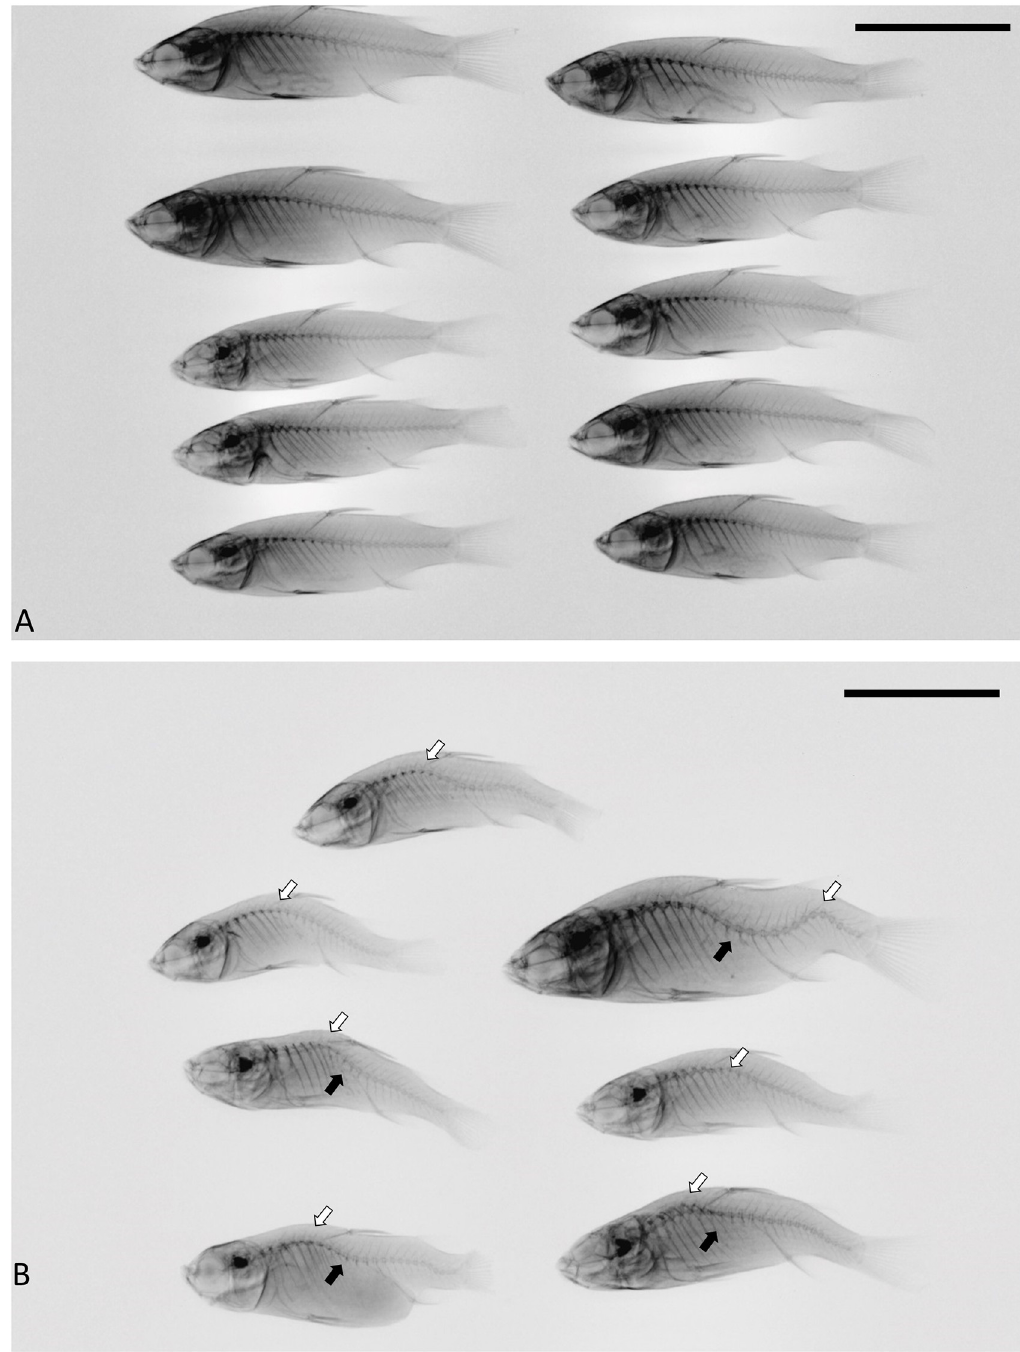
Fig 5. Lateral X-ray views of largescale mullet in Experiment 2. (A) Fish were transferred to 26˚C after the heat-treatment stage, or (B) exposure to 36˚C was continued for another 8 weeks. Open arrows indicate kyphosis, and solid arrows indicate lordosis. Scale bar, 10